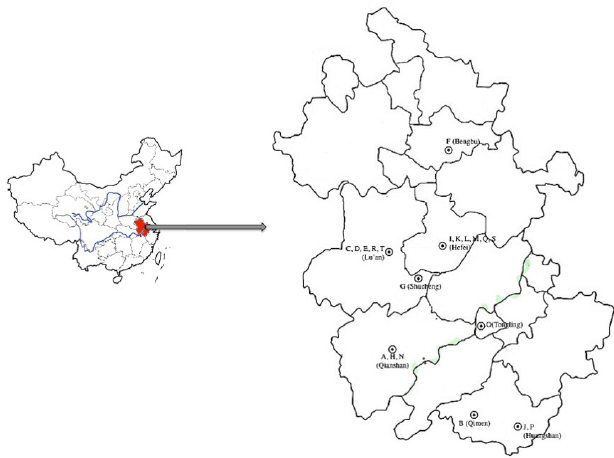
Fig 1 . Locations where O. formosanus populations were sampled in China. The explanation of A-T can be found in Table 1. The green shadow represented the Yangtze